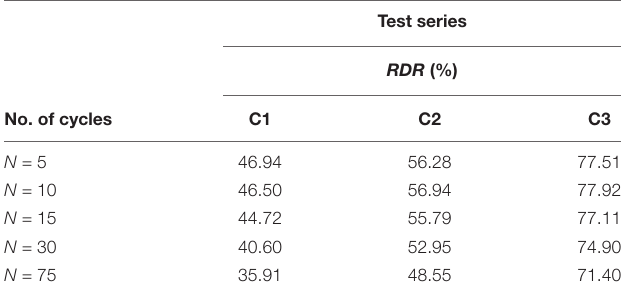
TABLE 3 | Rut depth reduction ( RDR ) for different reinforcement cases.